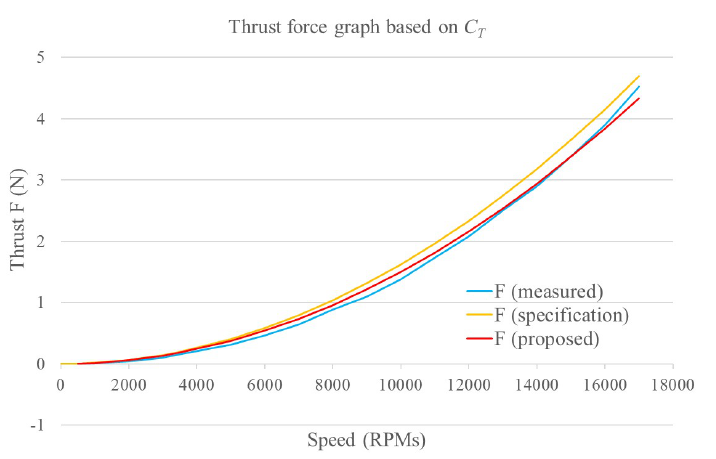
Figure 7. Thrust force graph from the thrust coefficient at different motor speeds using the measured coefficient, the motor manufacturer coefficient, and the proposed coefficient.